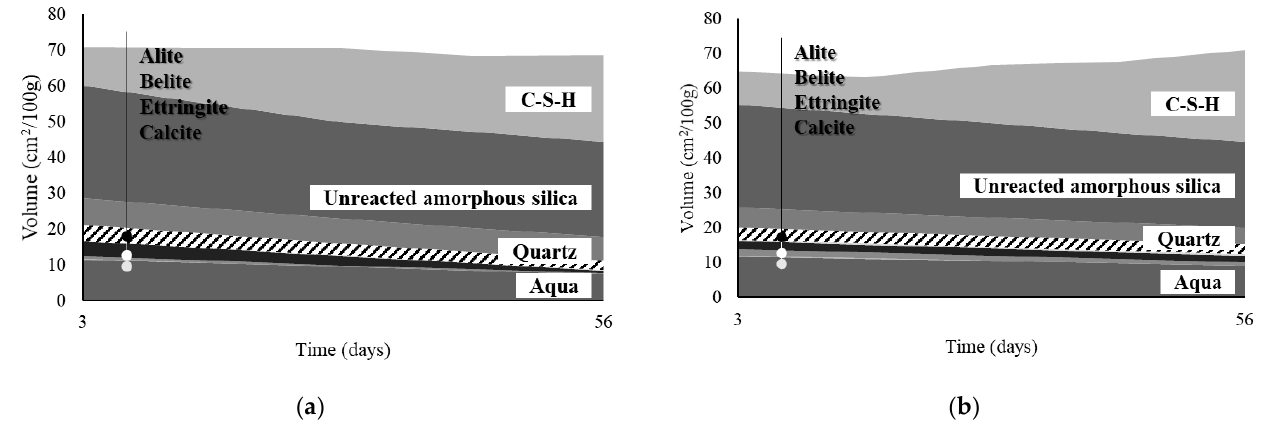
Figure 9. Thermodynamic modeling of samples: ( a ) S20 and ( b ) R20